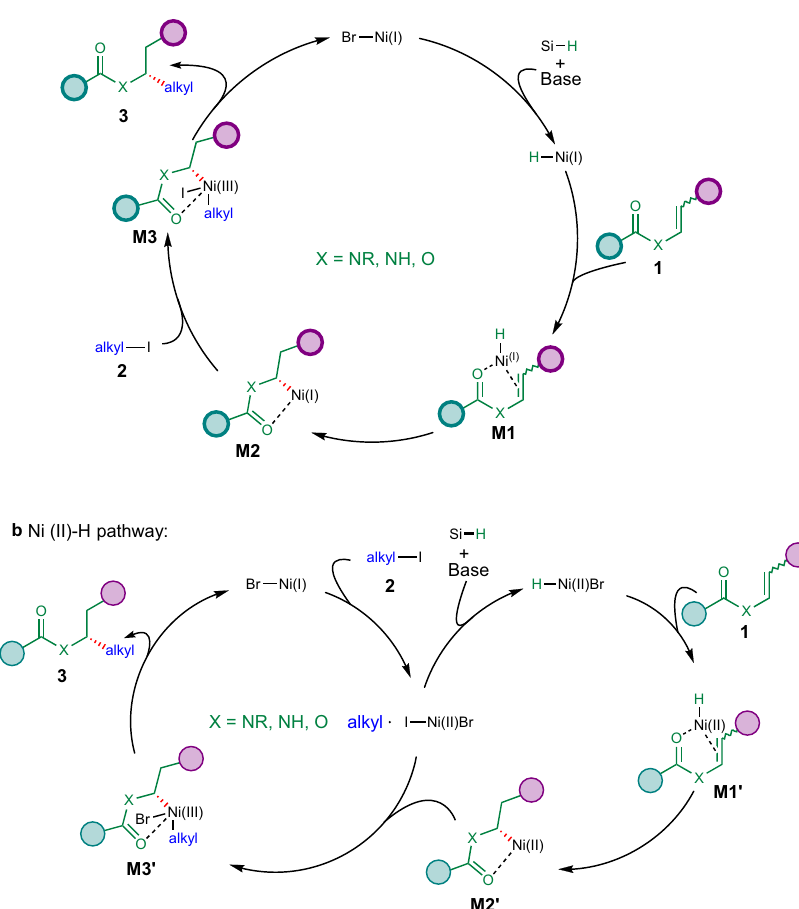
Fig. 7 Proposed mechanism for the reaction. Ligand is omitted for clarity. a Ni(I) – H pathway. b Ni(II) – H